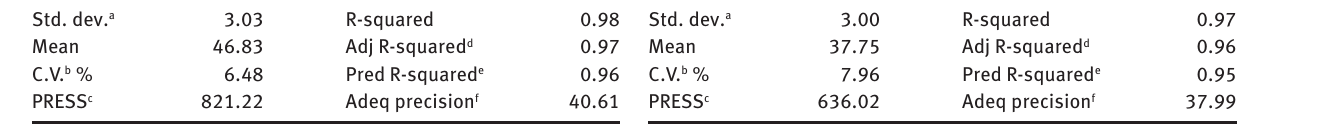
a Standard deviation, b Coefficient of variation, c Predicted residual sum of squares, d Adjusted R-squared, e Predicted R-squared, f Adequate precision.